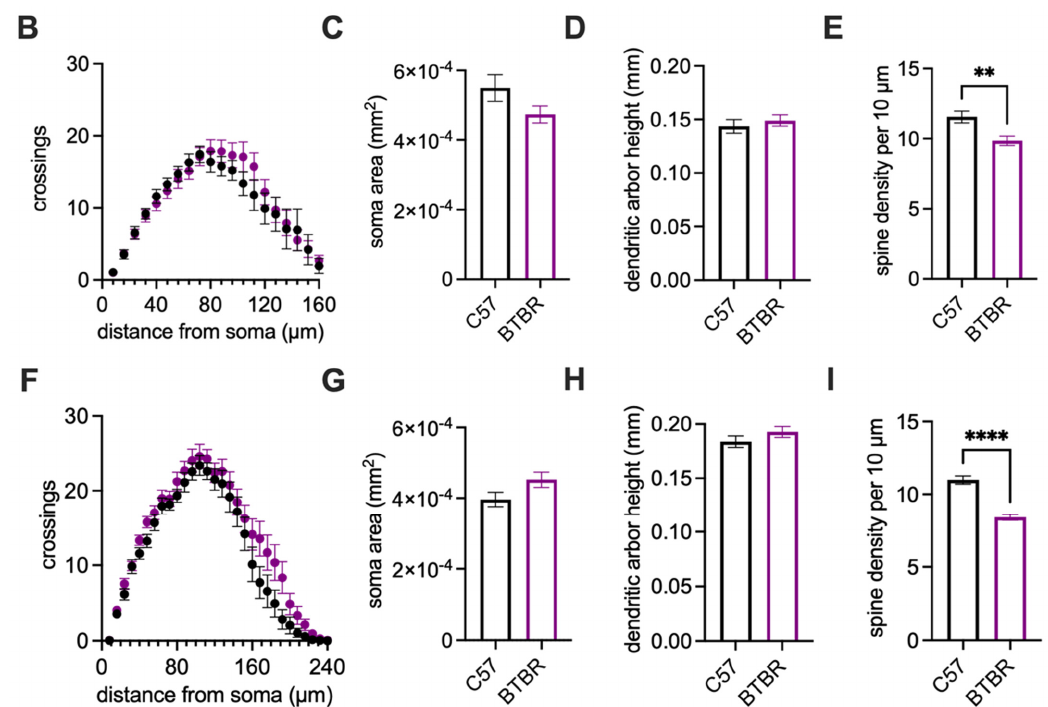
Figure 5. Male and Female BTBR mice show alterations to Purkinje cell dendritic branching and spine density. ( A ) Representative examples of Purkinje cells from BTBR (left) and C57 (right) mice. ( B ) Sholl analysis shows no difference between male BTBR and C57 mice. ( C ) Purkinje cell bodies are similar in area in male BTBR mice. ( D ) Dendritic arbor height is not different between groups of male mice. ( E ) Male BTBR mice have fewer dendritic spines on their distal branches. ( F ) Sholl analysis shows a slight increase in the complexity of dendritic arbors of Purkinje cells from female BTBR mice. ( G ) Purkinje cell bodies are similar in area in female BTBR mice. ( H ) Dendritic arbor height is not different between groups of female mice ( I ) Female BTBR mice have fewer dendritic spines on their distal branches. Black, C57B6/J mice; purple, BTBR mice. Error bars denote standard error of the mean. Asterisks denote significant results from two-sample t -tests ( C – E ) or planned comparisons following a significant two-way ANOVA ( B ). **, p < 0.01; ****, p < 0.0001.